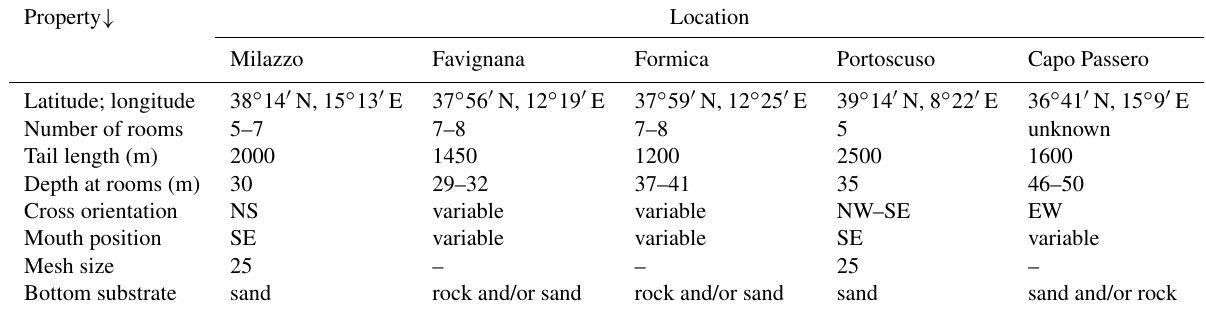
Table 1. Properties and deployment details of bluefin tuna traps regarded as sources of swordfish bycatch data in this study. Property ↓ Location